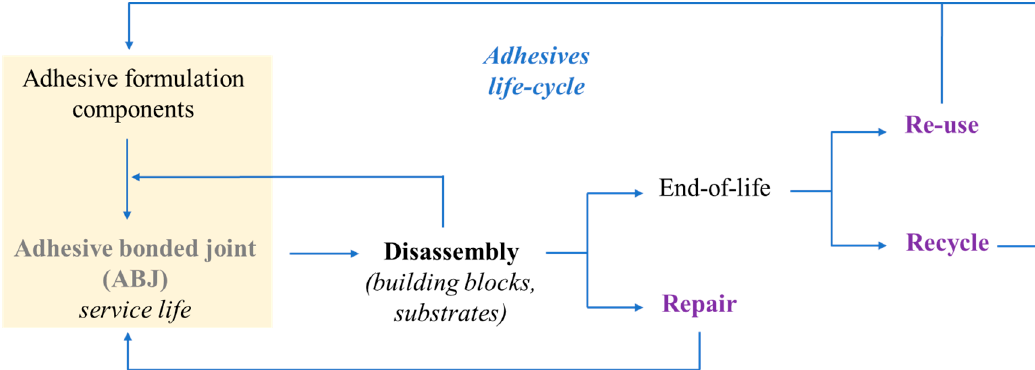
Figure 10. A life-cycle diagram, showing adhesive materials flows. Adapted from [177] “Overview of disbonding technologies for adhesive bonded joints”, A. Hutchinson, Y. Liu, et al. Journal of Adhesion, Vol 93, Pages No. 737–755, Copyright (2016), with permission from Taylor & Francis Ltd.,